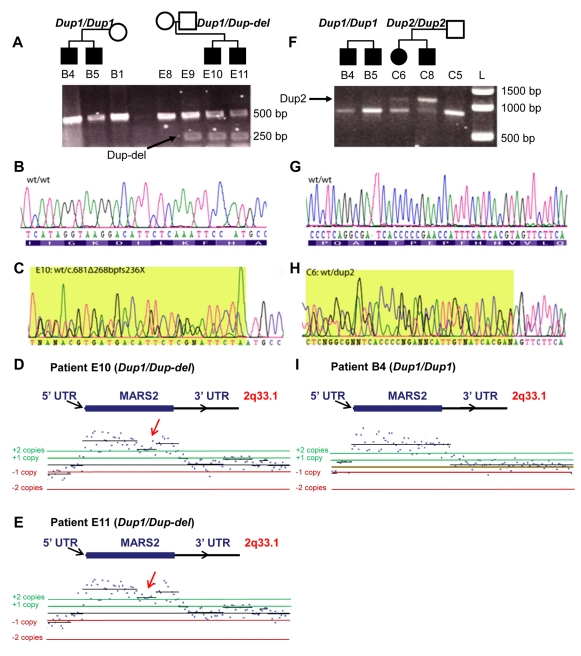
The human MARS2 mutations.(A) PCR amplification products of MARS2 encompassing a portion of the coding sequence revealed the presence of a 268 bp deletion mutation segregating in ARSAL Family E but not in Family B. This truncated product is indicated by an arrow. The normal PCR product is around 500 bp. Segregation of the deletion is shown in Family E; brothers E10 and E11 carry the mutation. Their unaffected father E9 is also a carrier. The determined genotypes for the patients shown (summarized in Table S5 for all patients) are shown above the PCR bands. (B) Wild-type sequence of MARS2 PCR products. (C) DNA sequencing of the deletion (c.681Δ268bpfx236X). (D–E) Nonrecurrent rearrangements involving the MARS2 gene was confirmed by the oligonucleotide custom aCGH. In patients E10 and E11, the array discriminated the presence of the duplication as well as the deletion (see arrows) as depicted by the lower band detecting only one additional copy. (F) PCR amplification products of MARS2 encompassing the coding sequence revealed the presence of a ∼300 bp insertion mutation segregating in ARSAL family members C6 and C8 but not in Family B. This larger amplification product is indicated by an arrow. The normal amplicon size is about 800 bp. C5 is the unaffected father of C6 and C8 and also carries the mutation. (G) Wild-type sequence of MARS2. (H) DNA sequencing of the heterozygous case C6 corresponding to the insertion revealed parts of the MARS2 duplication mutation. Rearrangement was confirmed by oligonucleotide custom aCGH. Note that the array data of C6, a compound heterozygote (Dup2/Dup2), demonstrates the presence of a potentially larger duplication while not showing the 300 bp insertion, the array not having been designed to include its sequence. (I) In homozygous patient B4 (Dup1/Dup1), the array suggests that the duplication has identical distal and proximal breakpoint junctions with the other ARSAL cases.